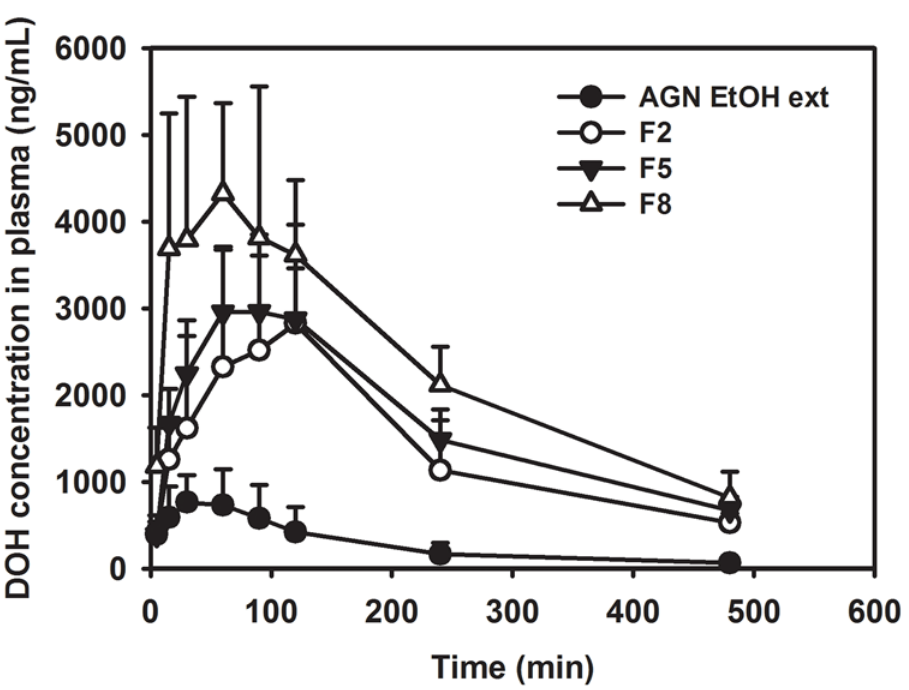
Fig 5. Pharmacokinetic profiles of DOH in plasma after oral administration of AGN EtOH ext, F2, F5, and F8 in rats. Each point indicates means ± SD (n = 3 – 5).